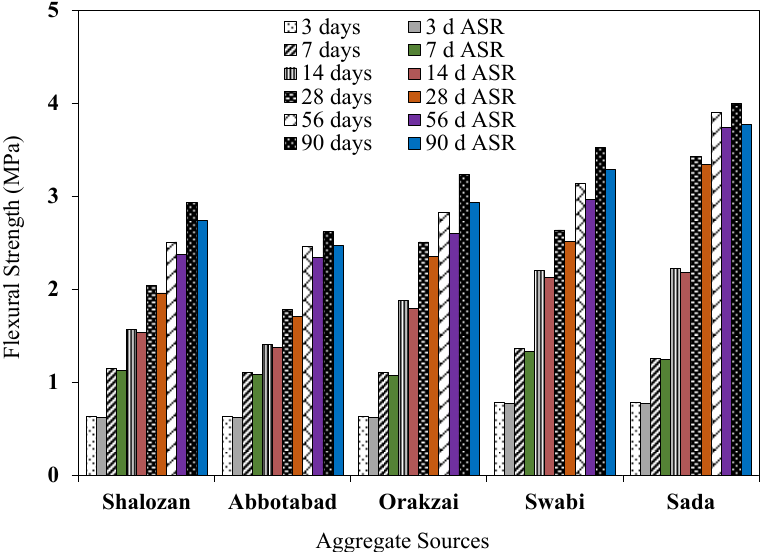
Figure 22. Variation in flexural strength of control samples and the samples under ASR conditions.